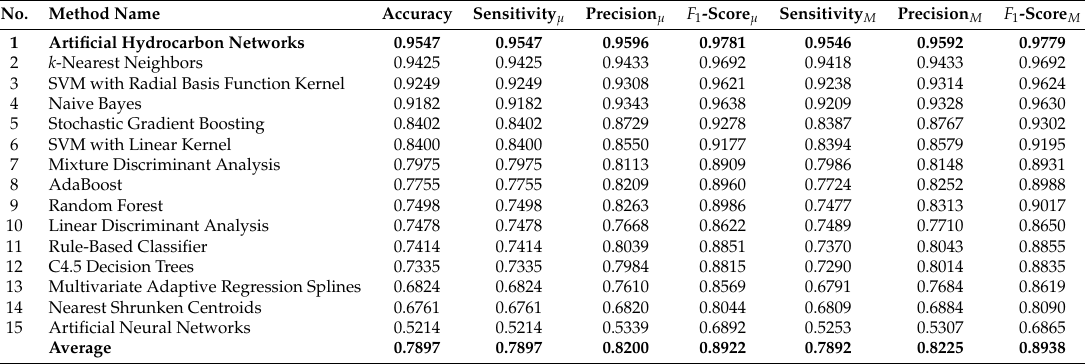
Table 9. Comparison of the supervised classifiers using the 15% noisy dataset of the case study.